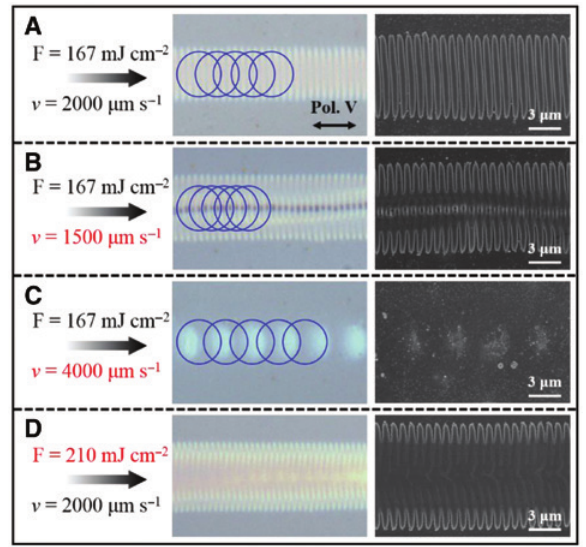
Figure 4: Morphology dependence of nanogratings on femtosecond laser